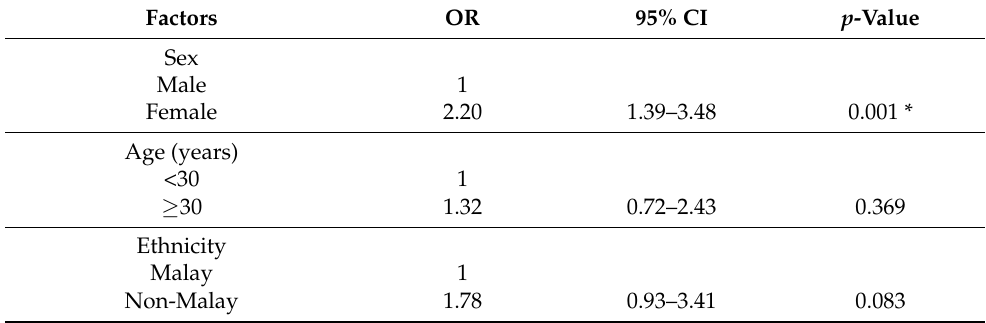
Table 3. Logistic regression analysis of various factors associated with dietary supplements use among